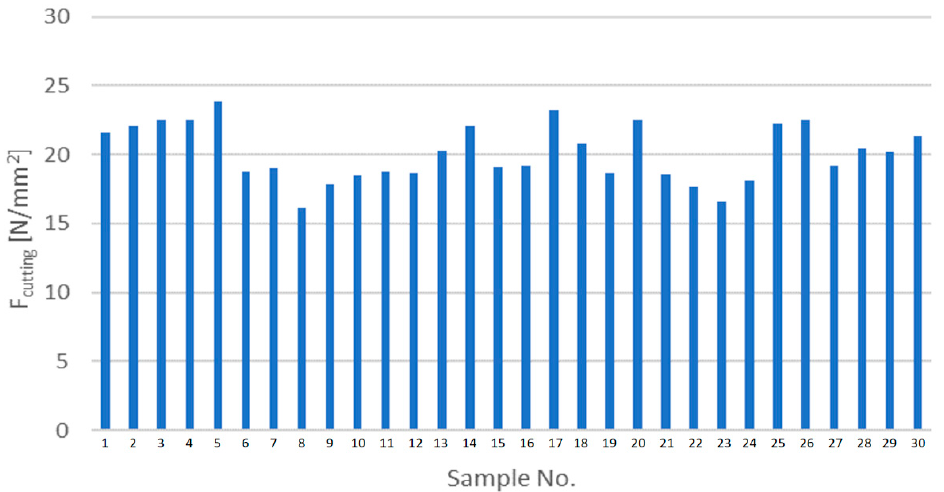
Figure 3. The average specific cutting forces from the winning experiments with cutting test equip- ment.